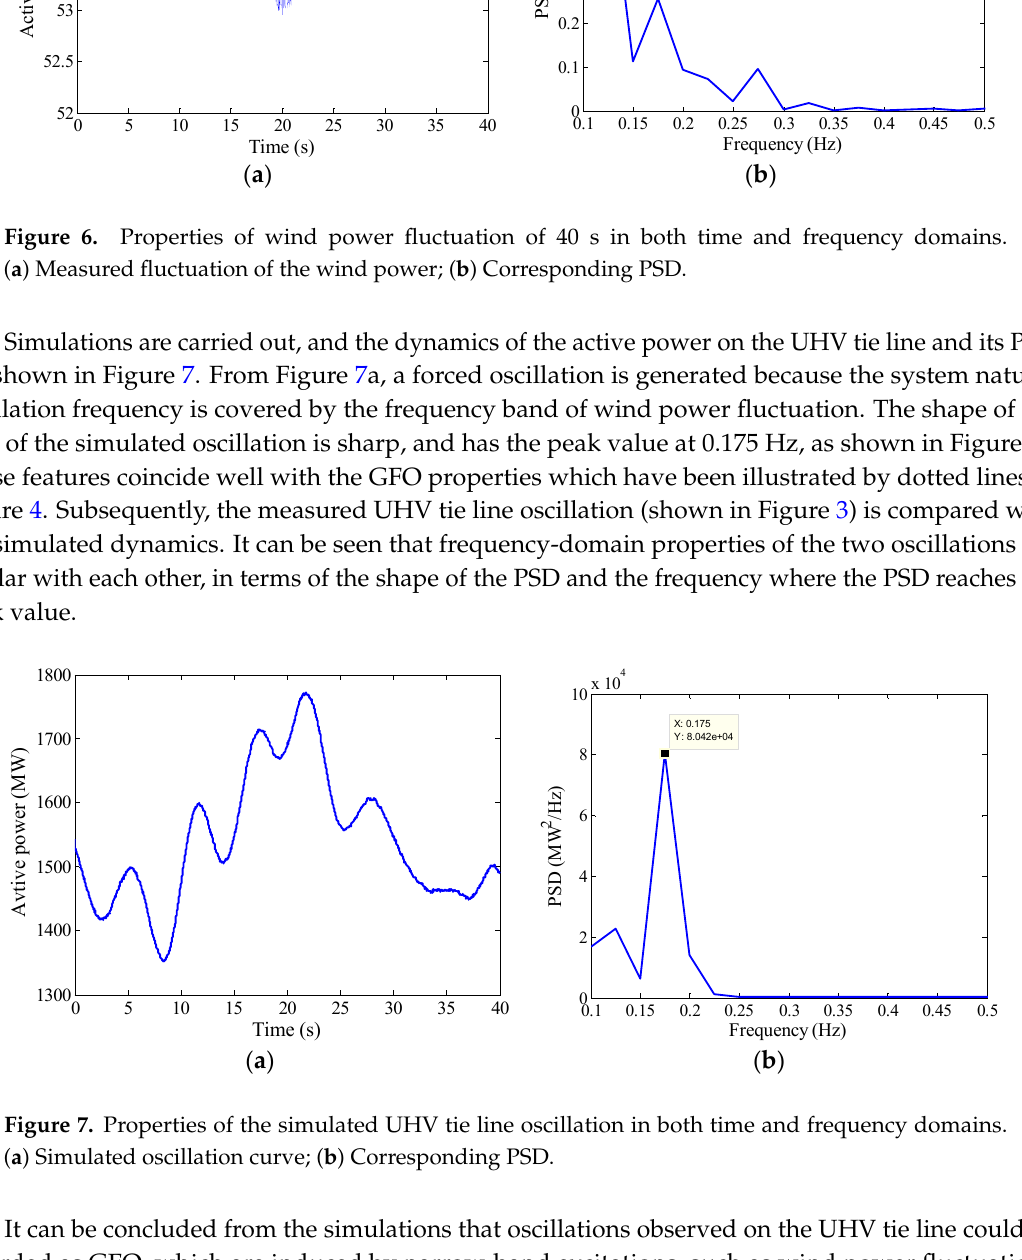
Figure 6. Properties of wind power fluctuation of 40s in both time and frequency domains. ( a ) Measured fluctuation of the wind power; ( b ) Corresponding PSD.